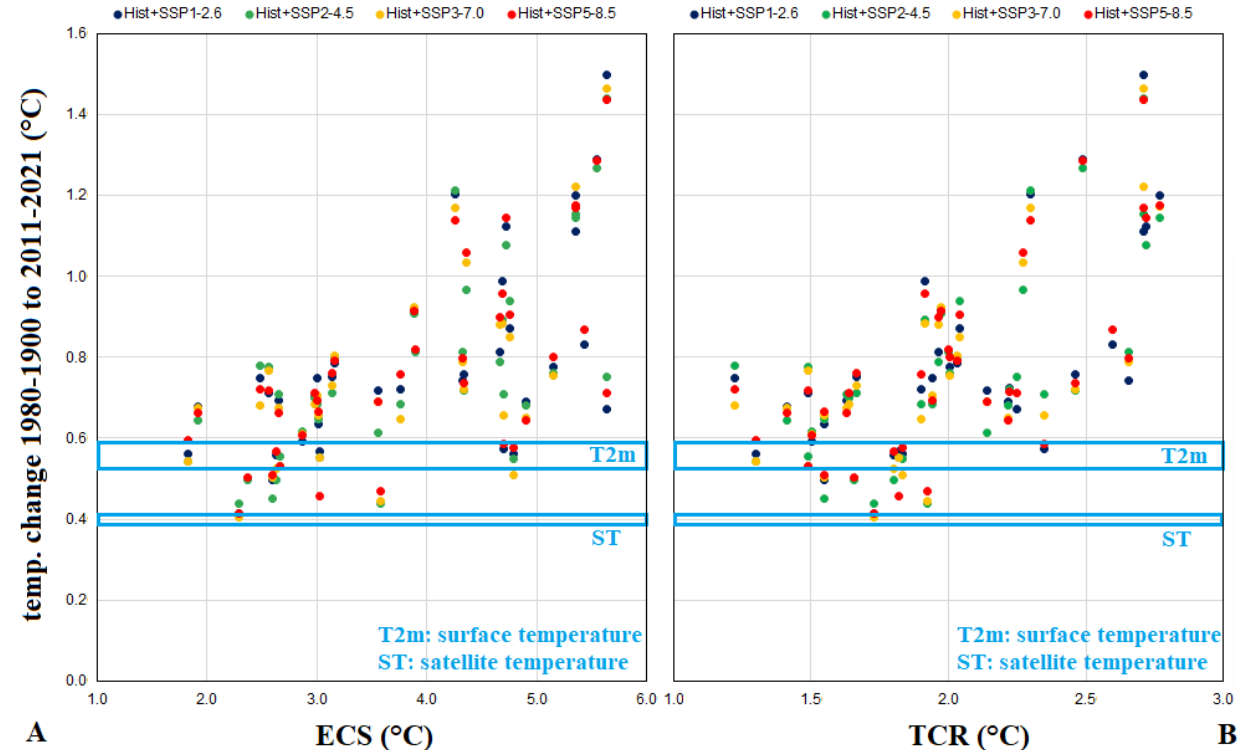
Figure 3. Temperature change from 1980–1990 to 2011–2021 for the CMIP6 Global Circulation Models (GCMs). Using ( A ) ECS-150 and ( B ) TCR ranking from Hausfather et al. [5]. See Table A2. The cyan boxes represent the warming ranges reported by the global surface temperature records (T2m) and by the UAH-MSU-lt v6 record